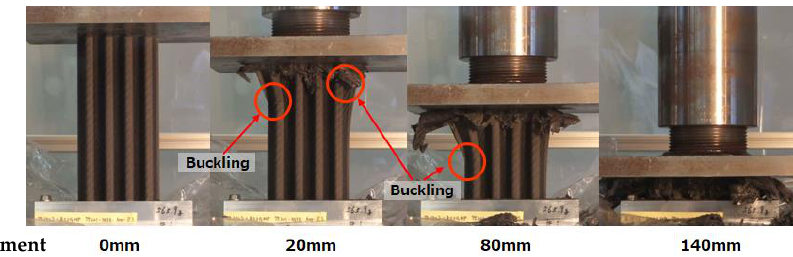
Figure 14. Nonprogressive crushing procedures of compression test (case: 16ply-P5).